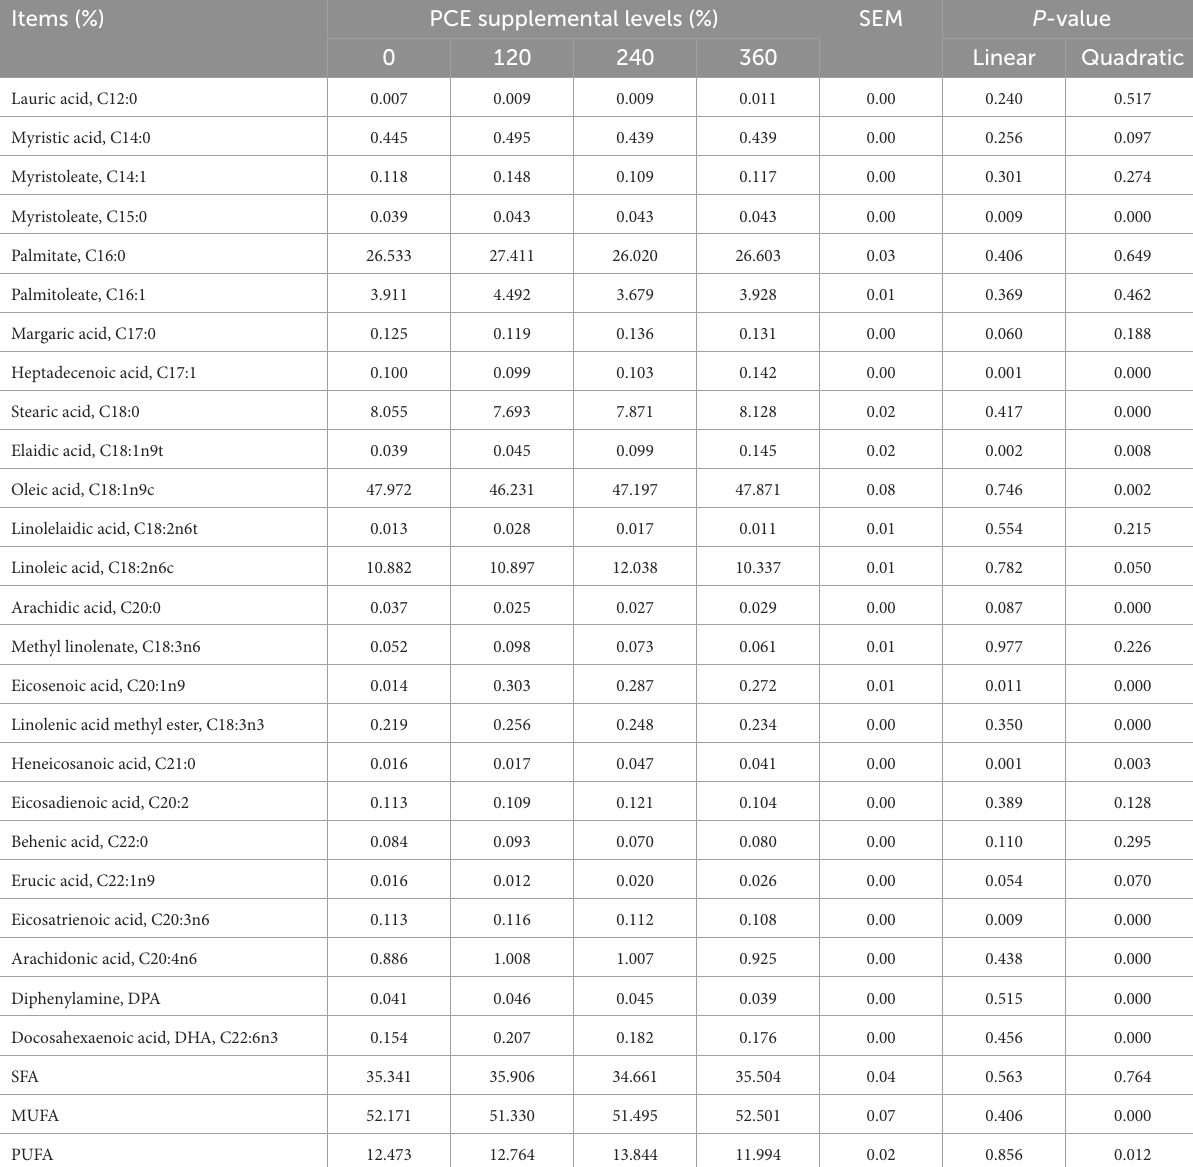
TABLE 6 Effect of purple corn extract on egg fatty acid profiles of 99-week-old laying hens. Items